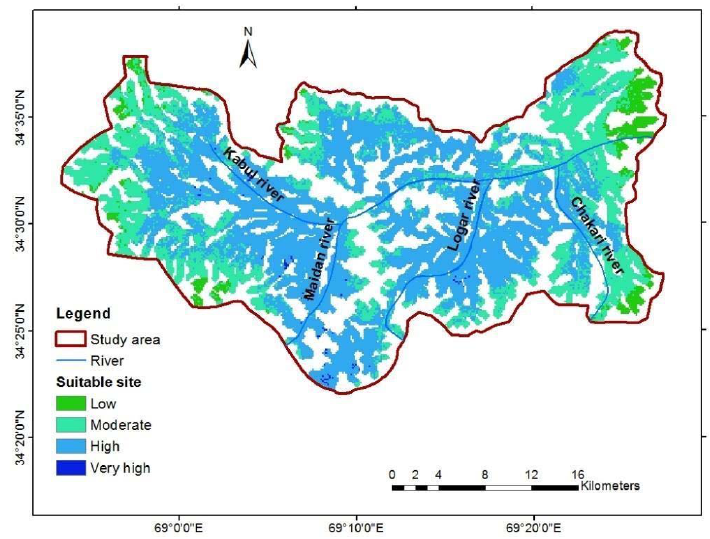
Figure 8. Map of groundwater recharge suitability for the Kabul aquifer.